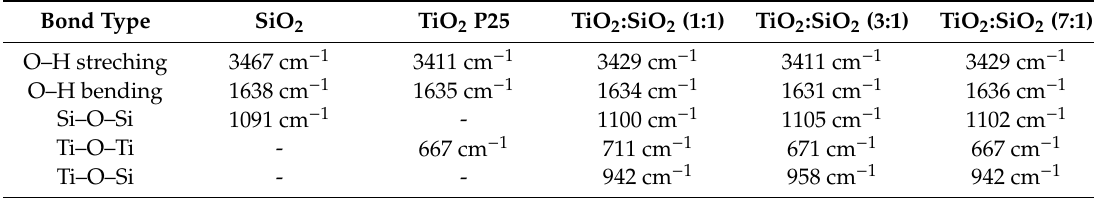
Table 3. Wavenumber of SiO 2 , TiO 2 P25 and TiO 2 / SiO 2 composite for FTIR characterization.